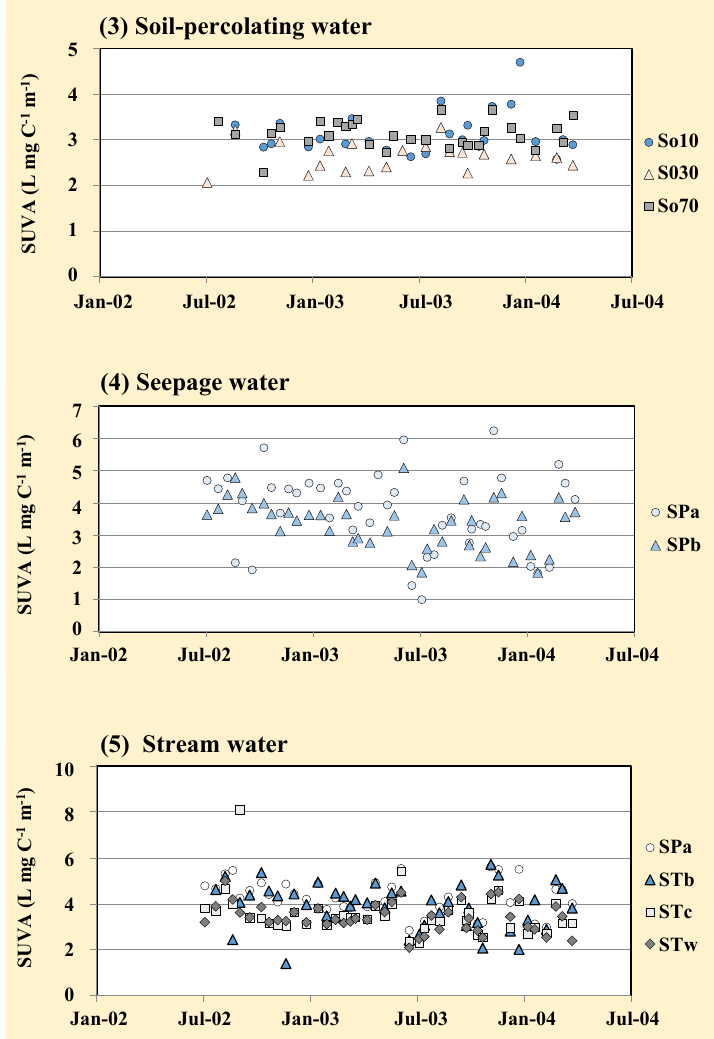
Figure 9. Seasonal variation of SUVA 254 for each sample type. See Figure 1 for the meaning of the